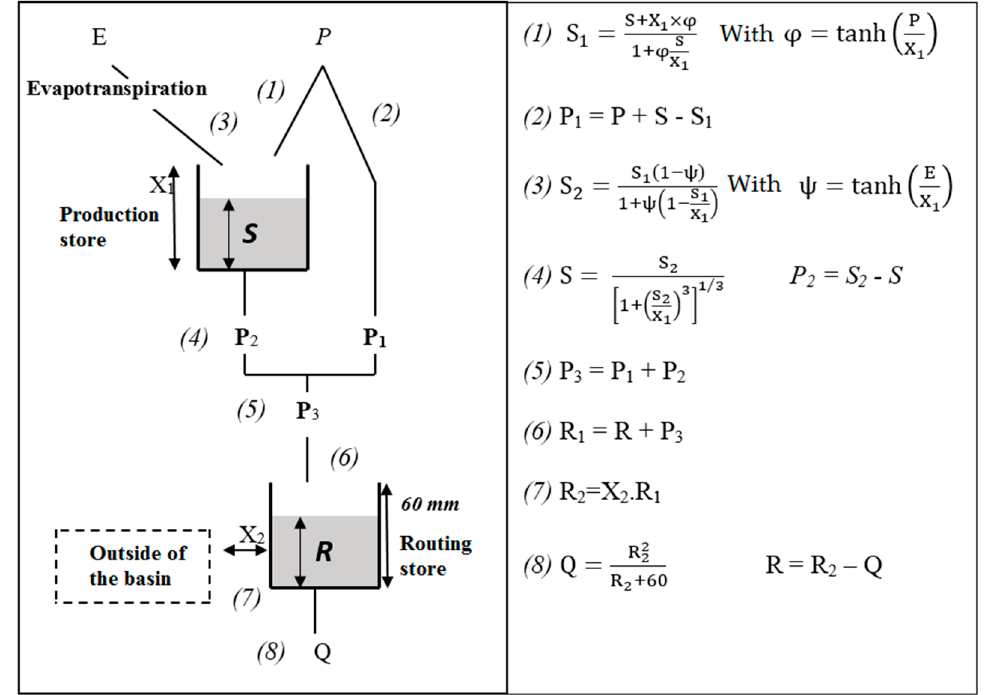
Figure 3. Scheme of the conceptual model GR2M (Source, [37]).